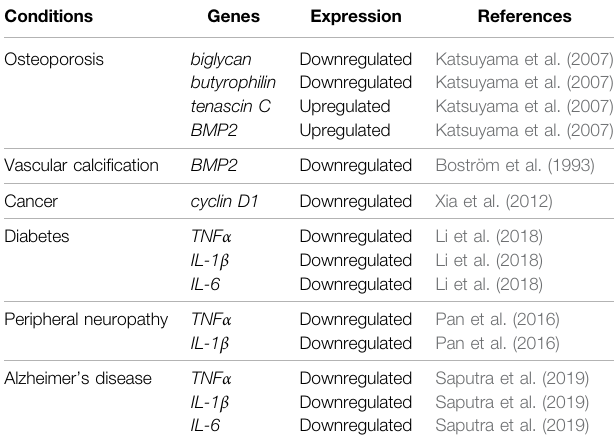
TABLE 2 | Genes modulated by vitamin K2-7 in various